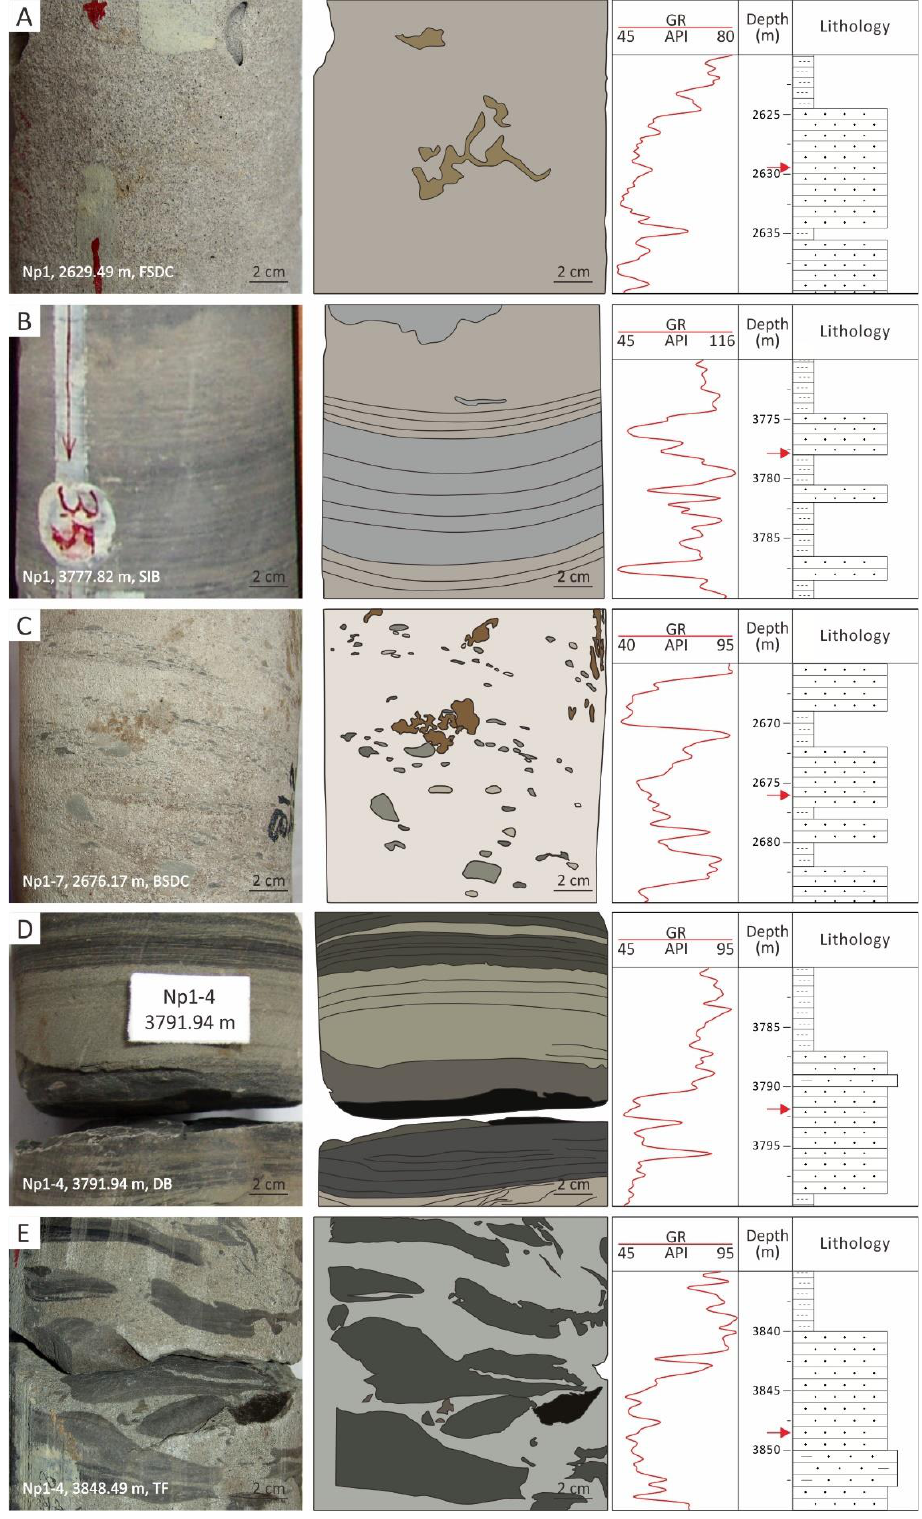
Figure 3. Core photographs of different sedimentary microfacies recognized in the No. 1 structural belt with a sketch and logging information attached to them. (See the well locations in Figure 1B.) ( A ) Np1, depth: 2676.17 m, submerged distributary channel (fan delta); ( B ) Np1, depth: 3777.82 m, submerged interdistributary bay; ( C ) Np1-7, depth: 2676.17 m, submerged distributary channel (braided delta); ( D ) Np1-4, depth: 3791.94 m, Distal bar; ( E ) Np1-4, depth: 3848.49 m, Turbidite fan.